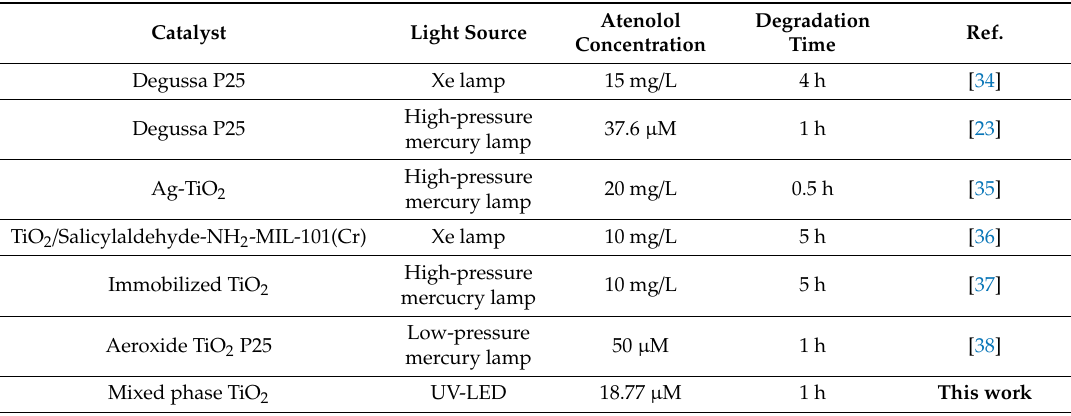
Table 2. The comparison of mixed phase TiO 2 with other reported TiO 2 photocatalysts towards photocatalytic decomposition of atenolol.